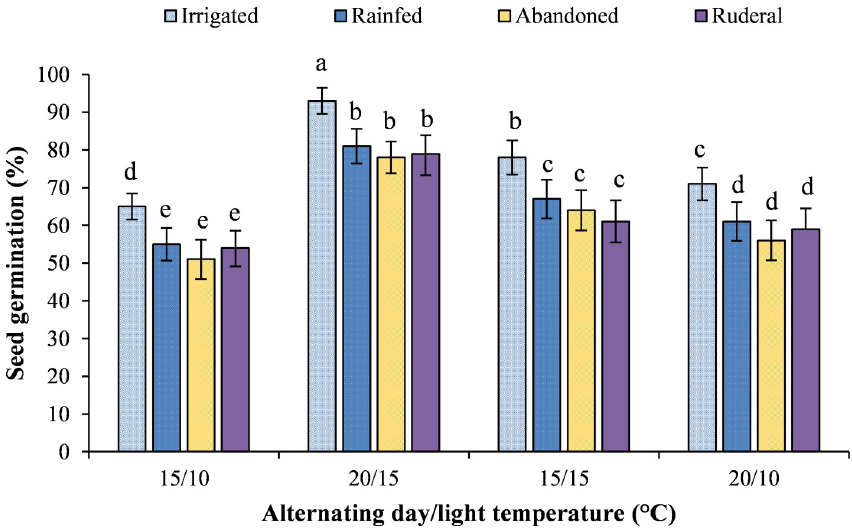
Fig 3. The influence of different alternating day/night temperatures on seed germination of Conyza stricta Willd. The vertical bars present standard errors of means (n = 10). Any to means sharing same letter are statistically non- significant (p > 0.05). LDS 0.05 =